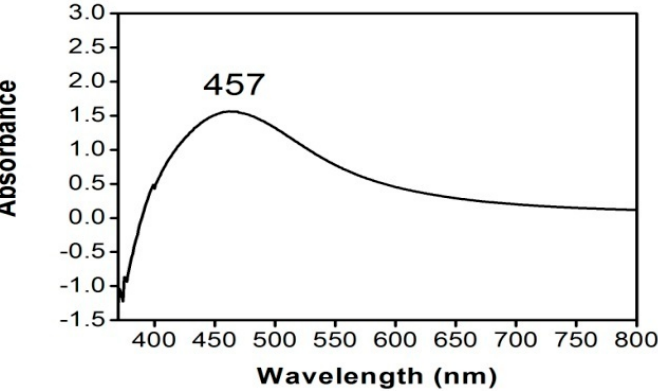
Figure 2. UV-Vis spectrum of biosynthesized AgNPs.